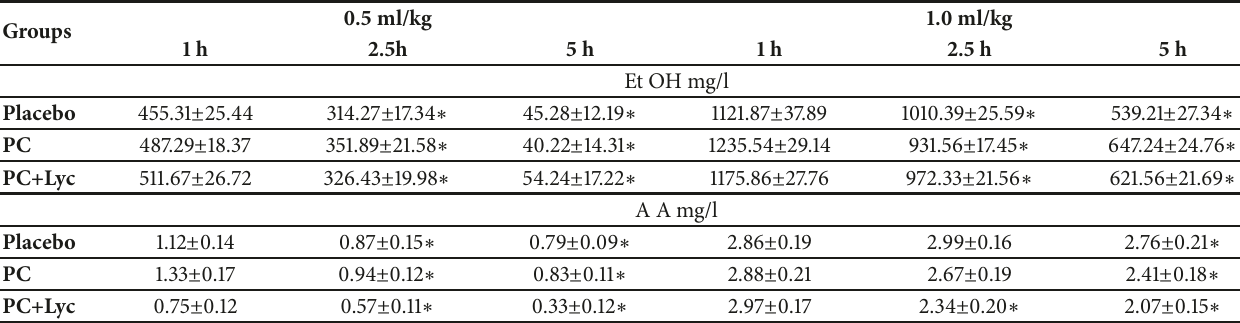
Table 2: Serum ethanol (EtOH) and acetaldehyde (AA) values (averages+/-SD). The volunteers were enrolled, screened, and randomized as described in the Material and Methods and given study products as well as alcohol-containing beverages. The parameters were measured after 1, 2.5, and 5 hours following the